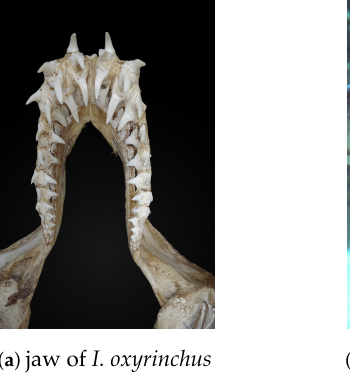
Figure 1. Shark teeth are arranged in series. Multiple rows of teeth grow behind each other and are continuously replaced over a lifetime. The primary function of the teeth of I. oxyrinchus ( a , b ) is to pierce (not cut) prey. The jaws of both shark species can be opened very wide to swallow prey in one